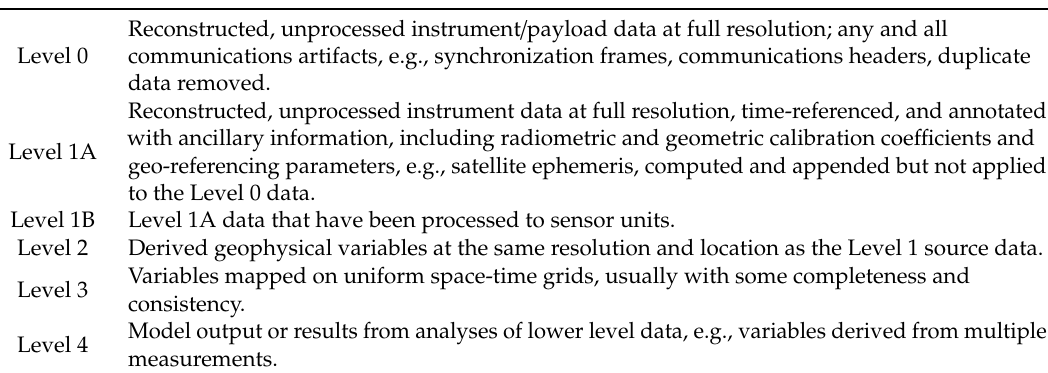
Table 2. NASA definitions of processing